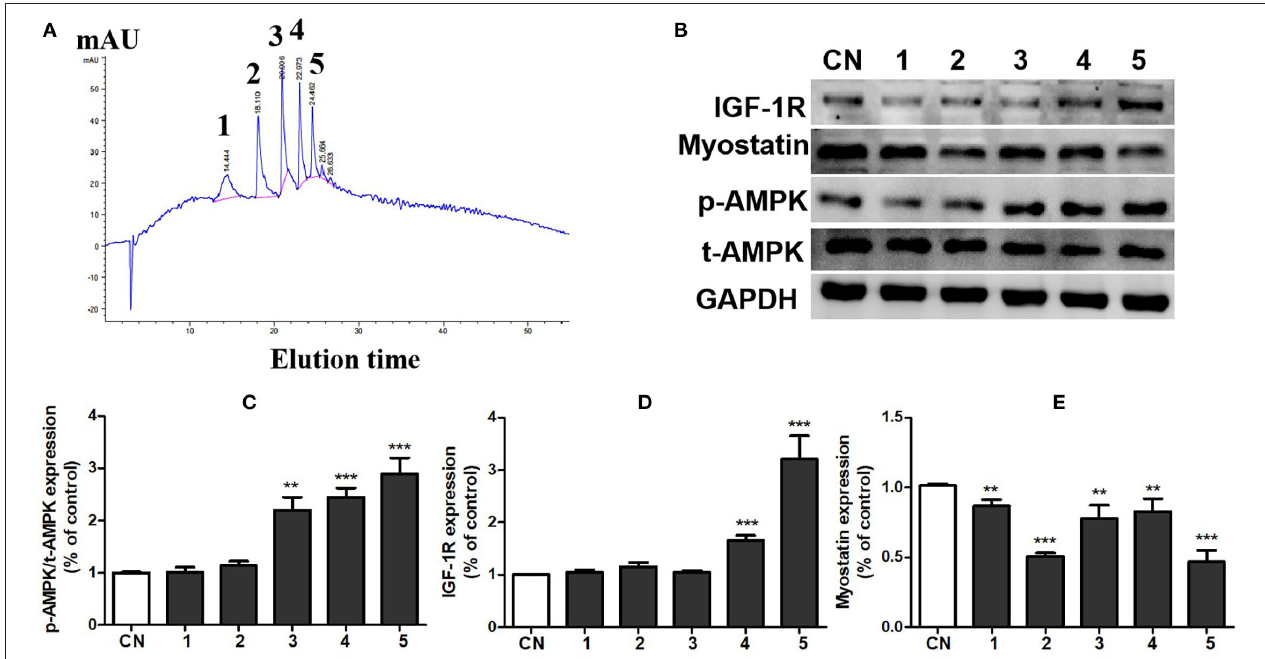
FIGURE 5 | Component 5 of pea peptide significantly activated muscle growth-signaling pathway. (A) Separation of pea peptides by HPLC; (B) expression of t-AMPK, p-AMPK, myostatin, and IGF-1R investigated by western blots; (C) statistical analysis of p-AMPK and t-AMPK expression; (D) statistical analysis of IGF-1R expression; (E) statistical analysis of myostatin expression. CN: Control group; RT: resistance training group; PP + RT: pea peptide supplementation combined with resistance training. The significant difference between groups was validated with one-way ANOVA using GraphPad Prism 6, ** p < 0.01, *** p < 0.001 vs. CN group (n = 5/group). Data are presented as mean ± standard deviation (M ±